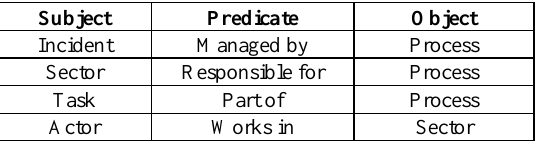
Figure 3. Conceptual diagram of top-level classes involved in DR in the Netherlands. Adopted